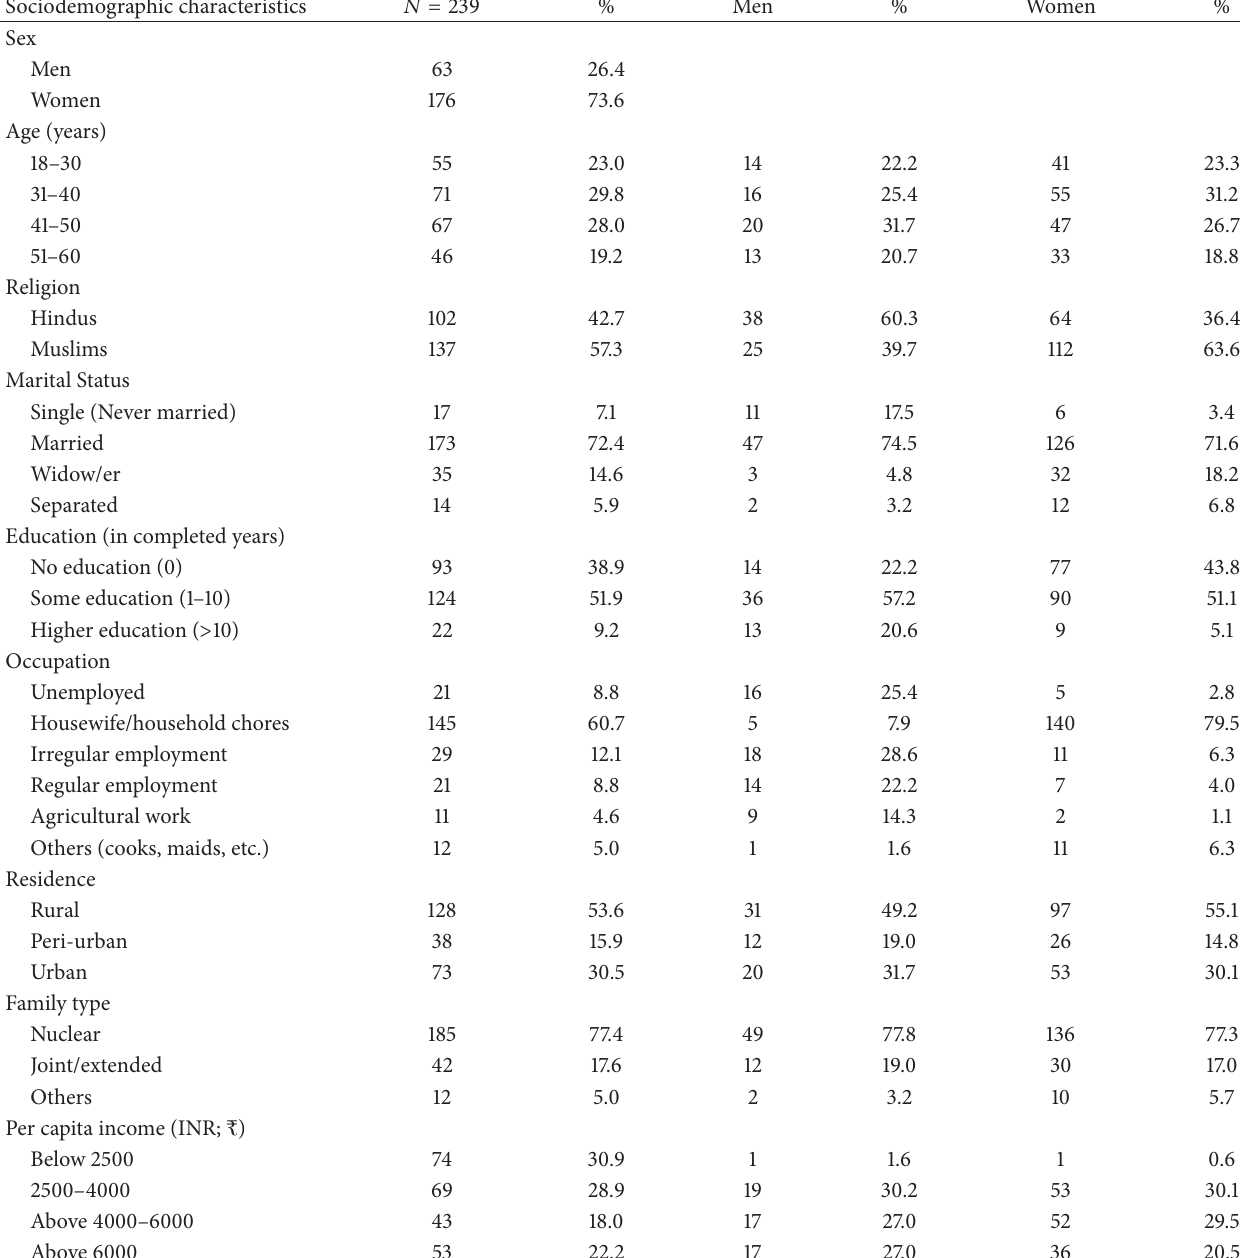
Table 1: Sociodemographic characteristics of the respondents ( 𝑁 = 239